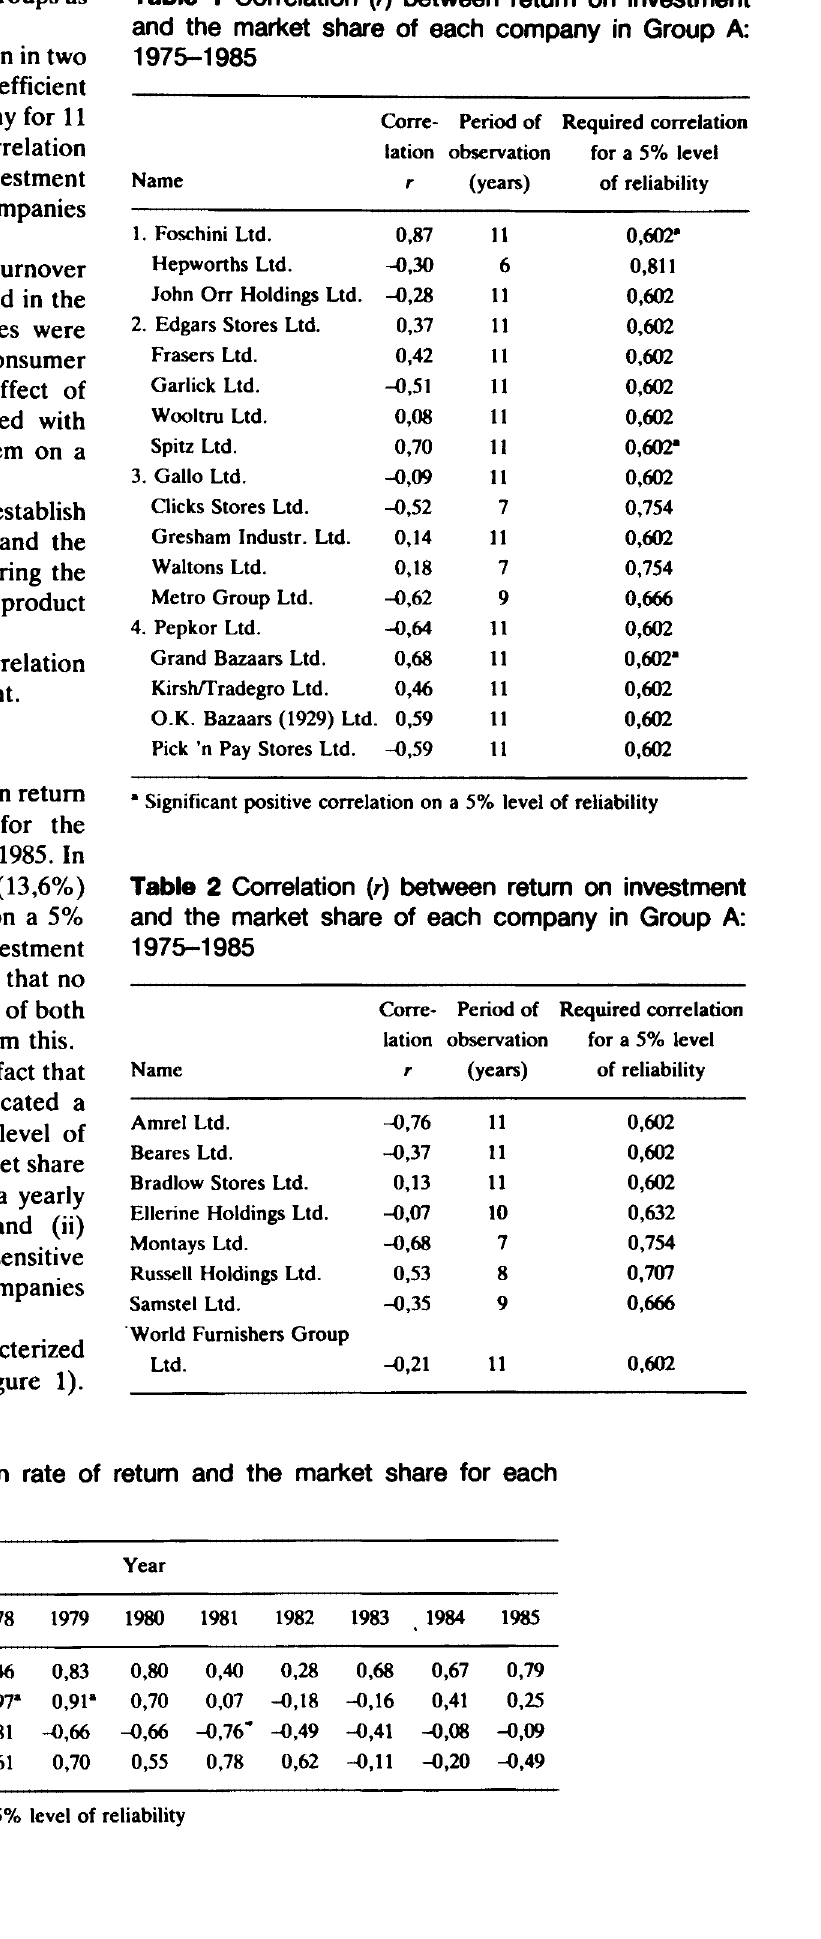
Table 3 Relationship between rate of return and the market share for